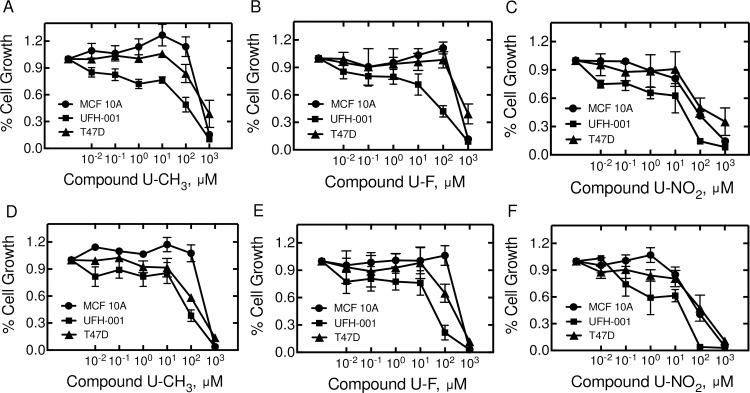
Effects of USBs on breast cancer cell growth.Breast cancer cell lines grown under normal culture conditions for 24 h were exposed to compounds for 48 h [U-CH3 (Panel A), U-F (Panel B), U-NO2 (Panel D)] or 96 h [U-CH3 (Panel D), U-F (Panel E), or U-NO2 (Panel F)]. MTT assay was performed at 48 h and 96 h, respectively. Data shown are an average of at least three independent experiments and are represented as the mean ± SEM.